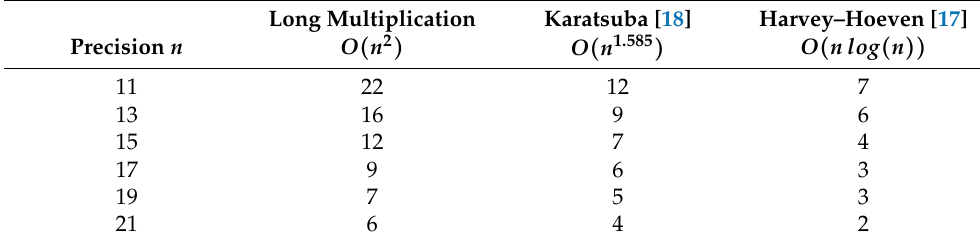
Table A2. Bit complexity gain of multiplication of two floating-point numbers with n -bit significance compared to the multiplication of two floating-point numbers with 52-bit significance